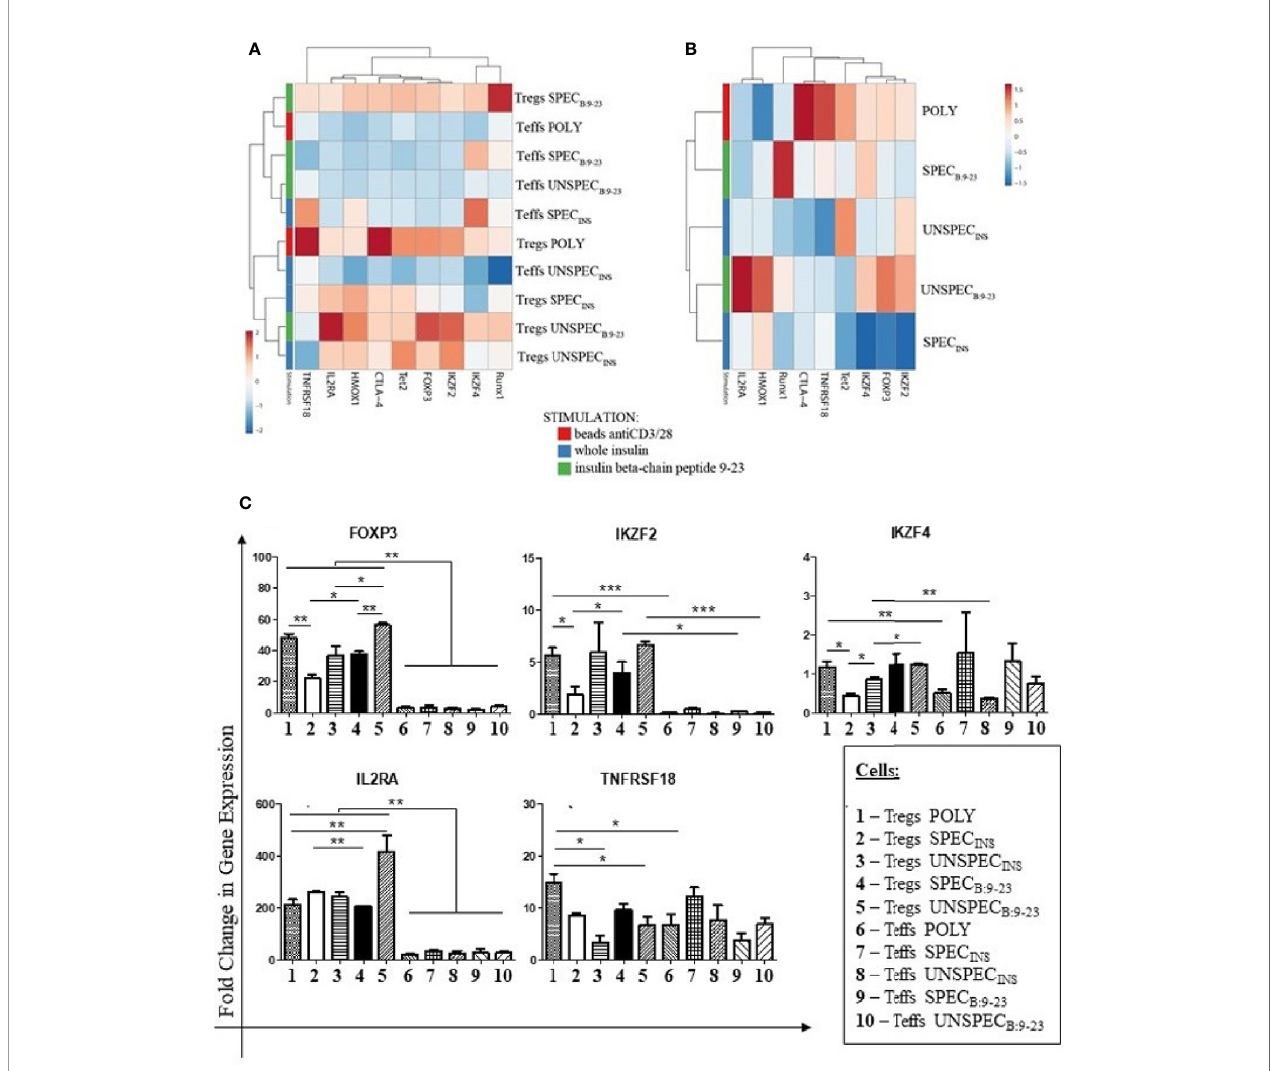
FIGURE 3 | Fold Change in Gene Expression in Tregs and Teffs. (A): Clustering and heat maps analysis of gene expression in Tregs: POLY, SPEC, UNSPEC and Teffs: POLY, SPEC, UNSPEC. (B) Clustering and heat maps analysis of gene expression only in Tregs. (C) Graphs presenting changes in cells populations. Only the expressions in which statistical signi fi cance occurred are presented. The cells were stimulated with beads anti-CD3/anti-CD28 (index POLY) or monocytes loaded with whole insulin (index INS) or insulin b chain peptide 9-23 (index B:9-23). The cells responding to antigen have an index SPEC, cells not recognizing the antigen have an index UNSPEC. All stimulations were performed in triplicates (three tests for whole insulin and three tests for insulin b chain peptide 9-23). The results are presented as mean+/- SD. Signi fi cance was calculated using the t- test, signi fi cant results are marked with * (p<0.05), ** (p<0.01) or *** (p<0.001). Heat maps were prepared using ClustVis tool based on correlation distance and average linkage between clusters